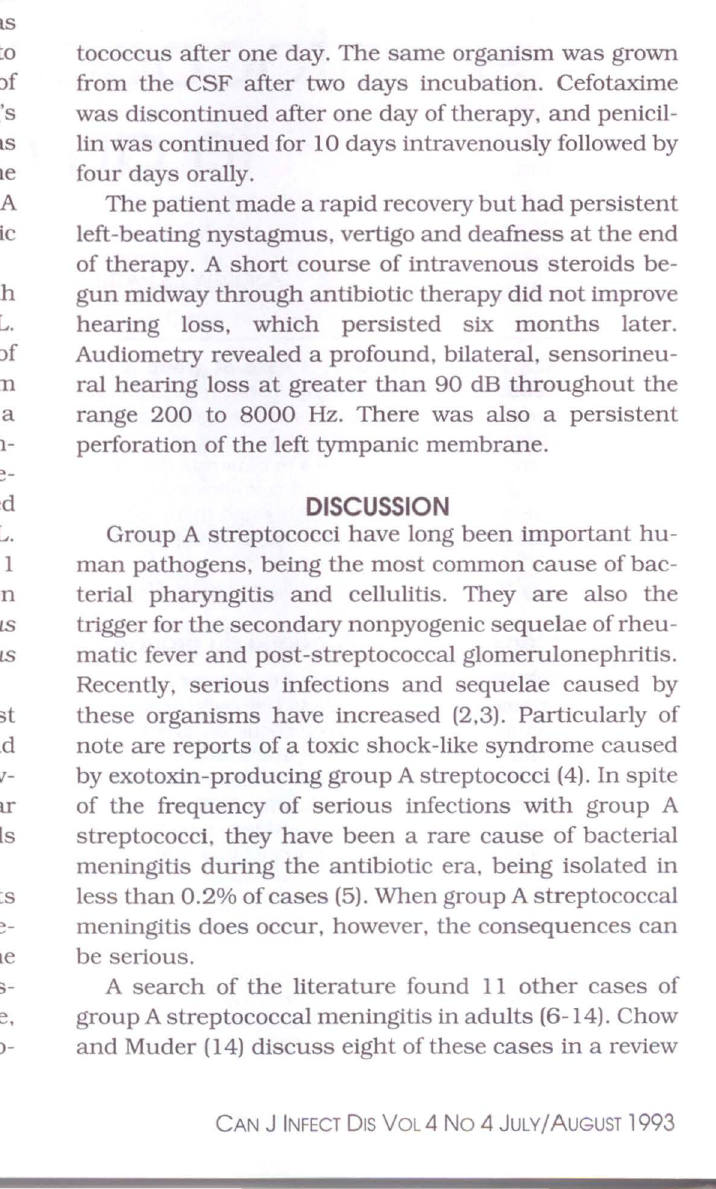
Figure 1) Computed axial tomography scan through the left mastoid showingjliud in several of the air cells, consistent with